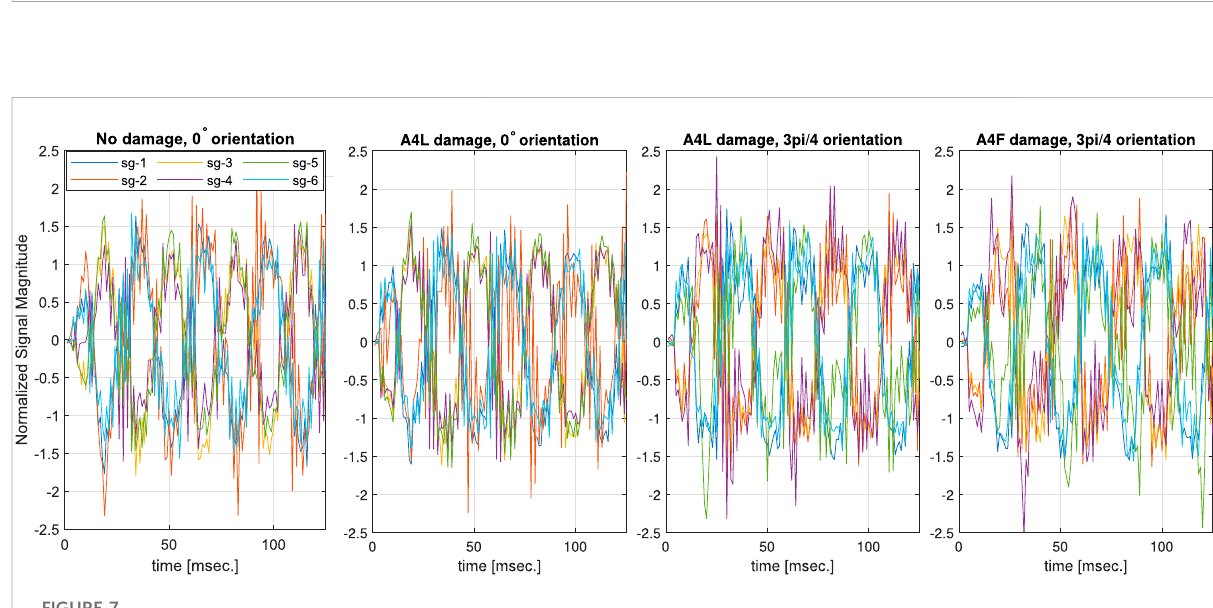
FIGURE 7 Normalized force (sg-1 – sg-3) and torque (sg-4 – sg-6) strain gauge signals for four damage con fi gurations. The plots show that differences between two signals of different damage locations but in the same gripper orientation are not